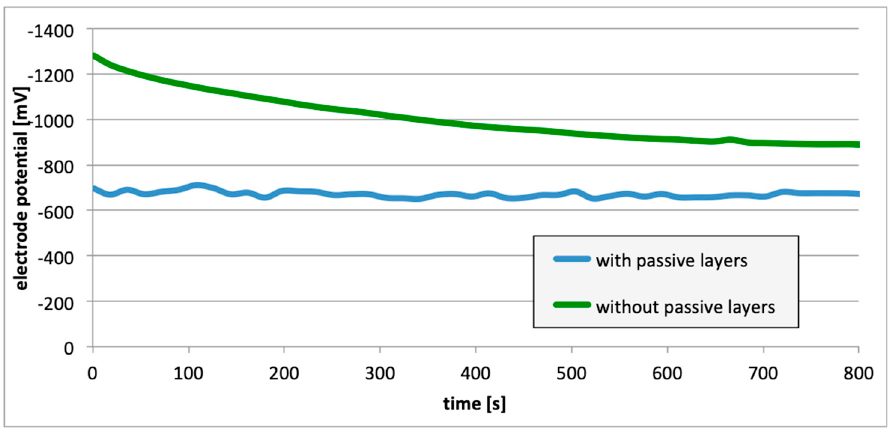
Figure 13. Electrode potential change following removal of passive layers (EN AW-1050A).